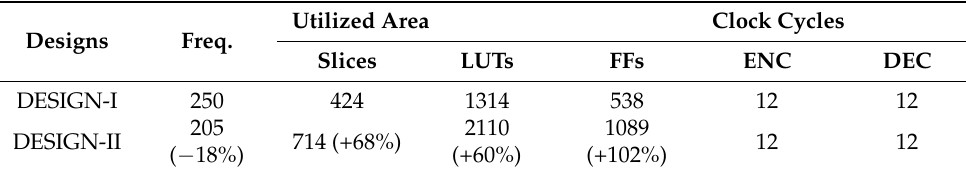
Table 1. Area and clock cycles information on a Zynq 7020 SoC (Artix-7 device).